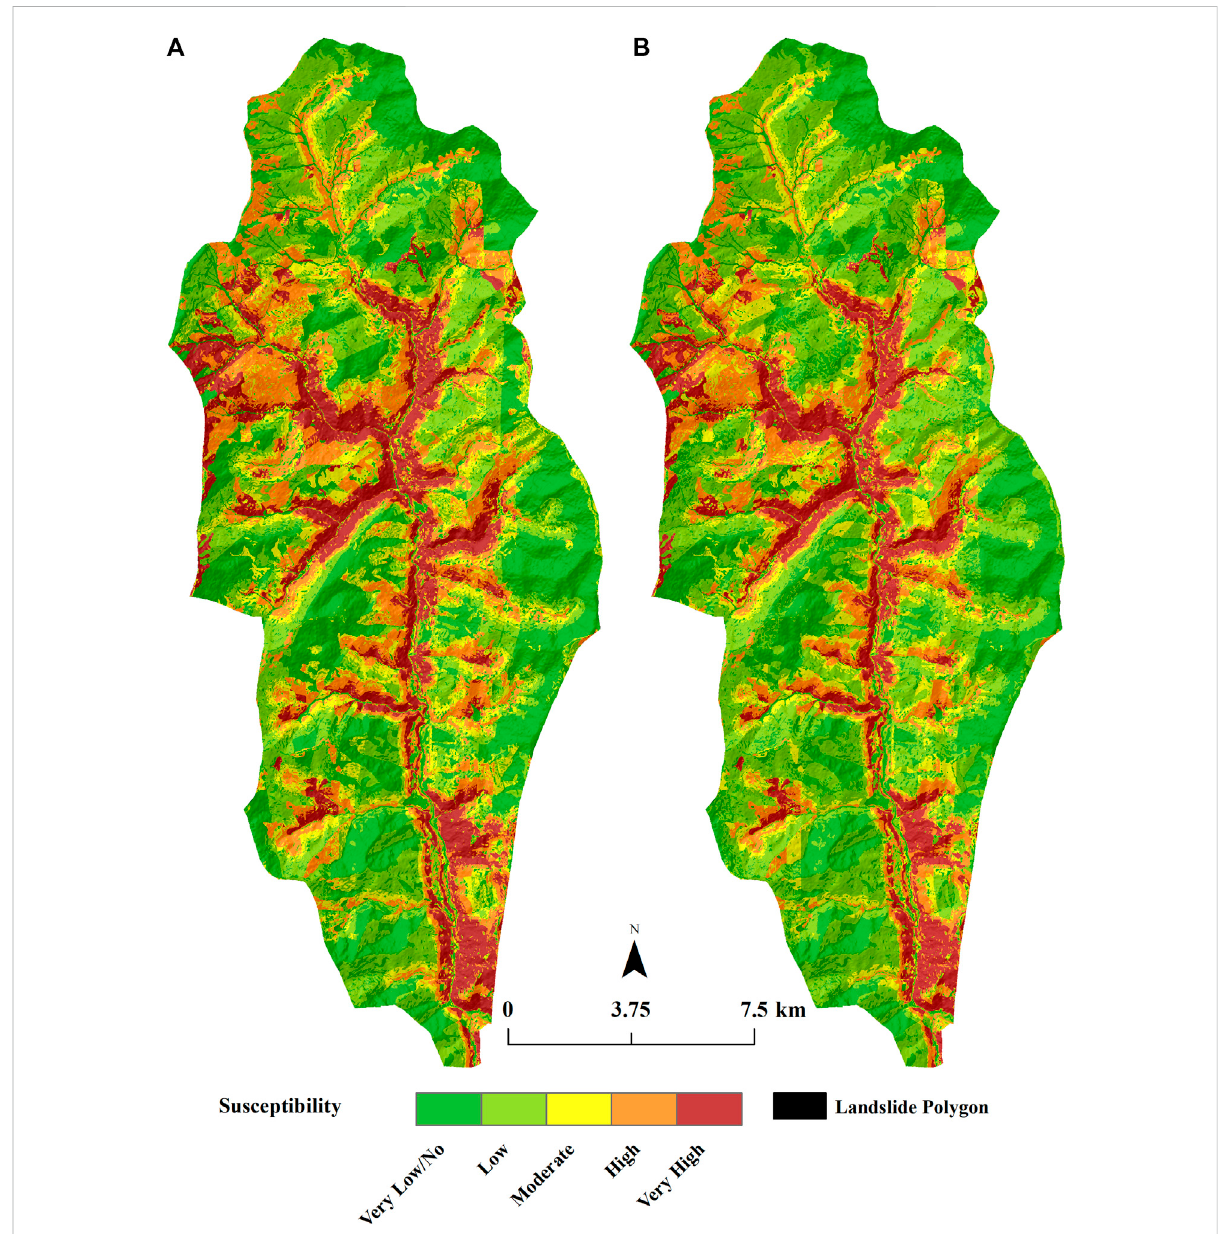
FIGURE 6 Shahpur valley: (A) WoE-based landslide susceptibility zones and (B) IV-based landslide susceptibility